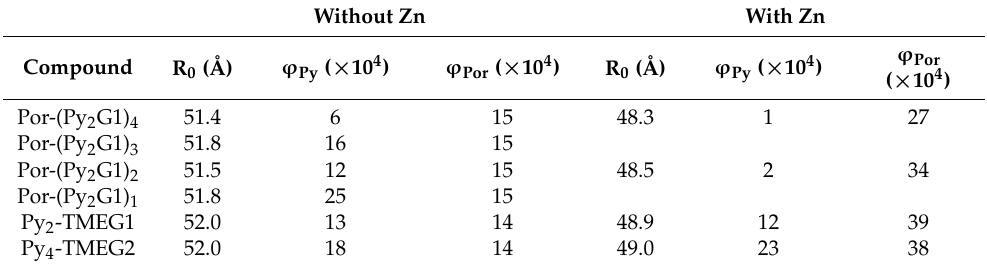
Table 2. Förster radii (R 0 ), pyrene monomer quantum yield ( ϕ Py ), and porphyrin quantum yield ( ϕ Por ) obtained by exciting the solutions at 344 nm. Reprinted with permission from (Zaragoza-Gal á n, G., Fowler, M., Rein, R., Solladi é , N., Duhamel, J., & Rivera, E. (2014). Fluorescence Resonance Energy